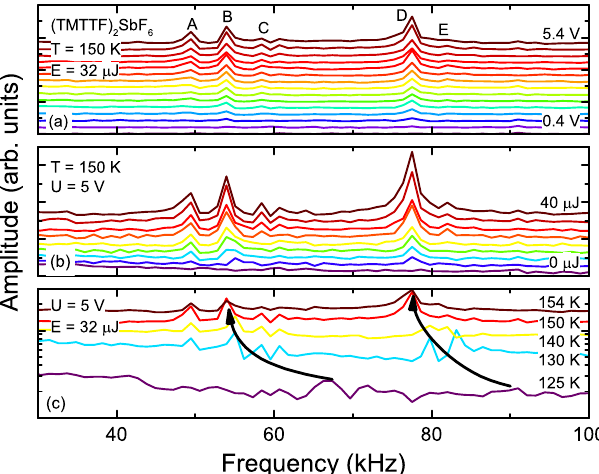
Figure 10. Amplitude spectra of the current oscillations in (TMTTF) 2 SbF 6 obtained by fast Fourier transformation. The curves are shifted by a constant value for better visualization. Amplitude spectrum in a frequency range from 30 kHz to 100 kHz plotted ( a ) for various voltages from U = 0.4 V to 5.4 V and for a laser pulse energy of 32 µ J at 150 K; ( b ) Same temperature and frequency range as in ( a ), however, the amplitude spectra are shown for different laser pulse energies at a fixed voltage of 5 V. ( c ) Temperature-dependent amplitude spectra from T = 154 K to 125 K for 32 µ J and 5 V. The black arrows indicate how the current oscillations shift in frequency as the temperature is